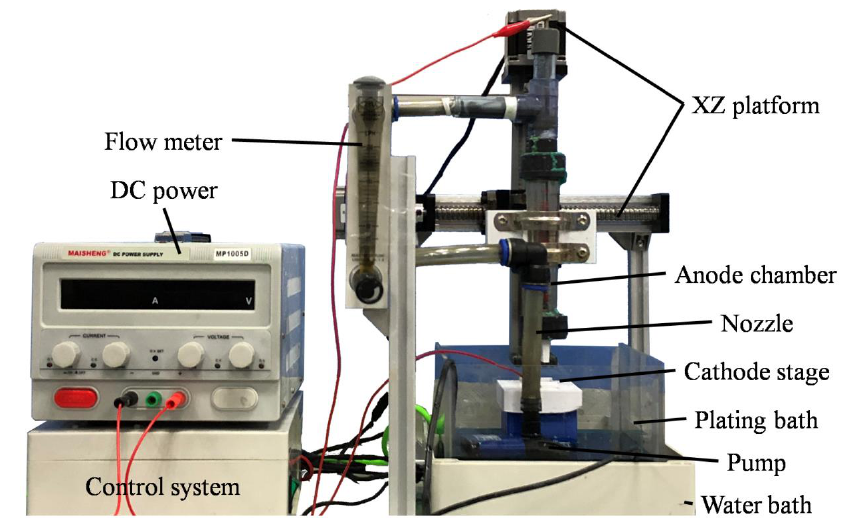
Figure 2. The jet electrodeposition device.